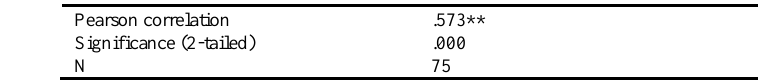
Table 6. Spelling and writing attitude relationship